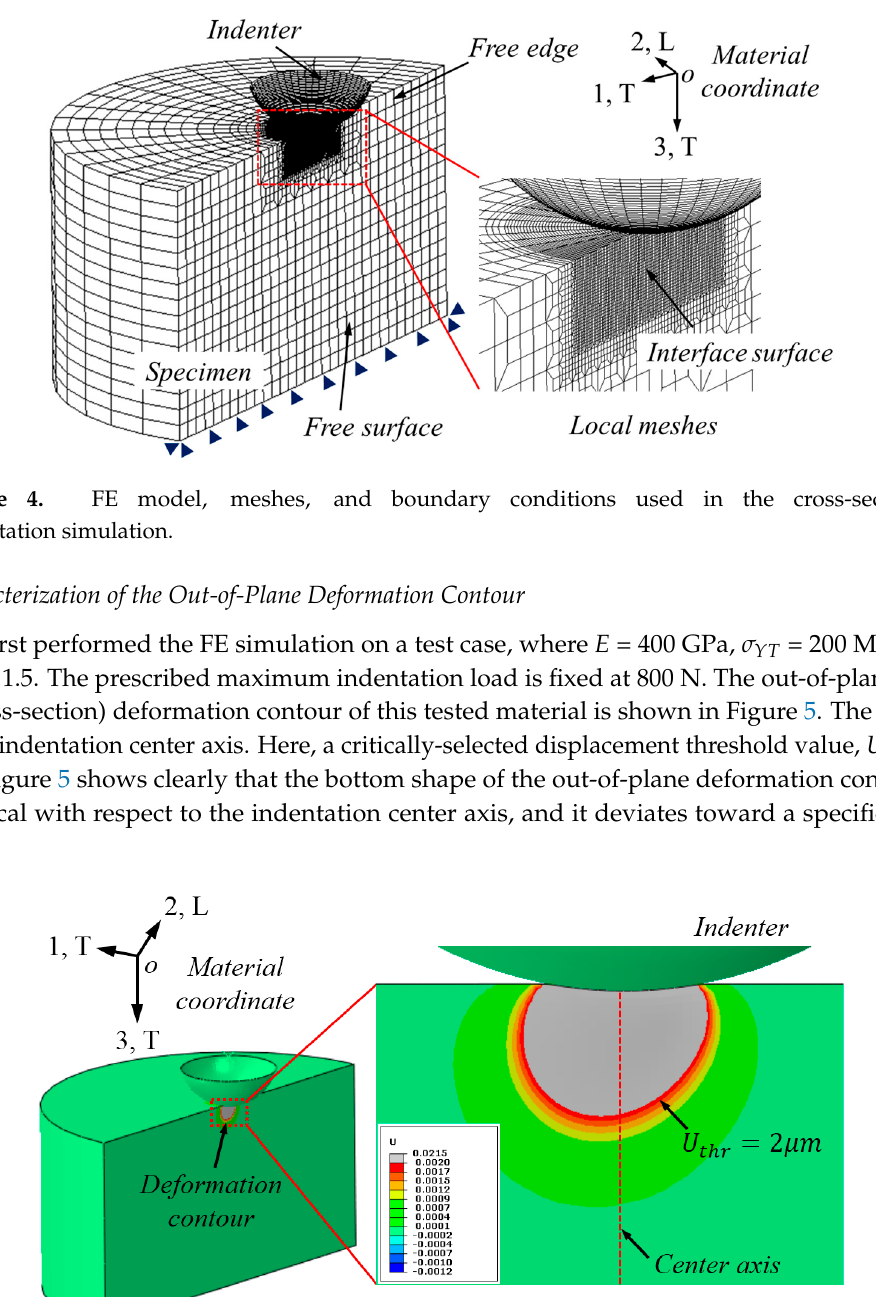
Figure 5. Out-of-plane deformation contour persisting on the cross-section after unloading.